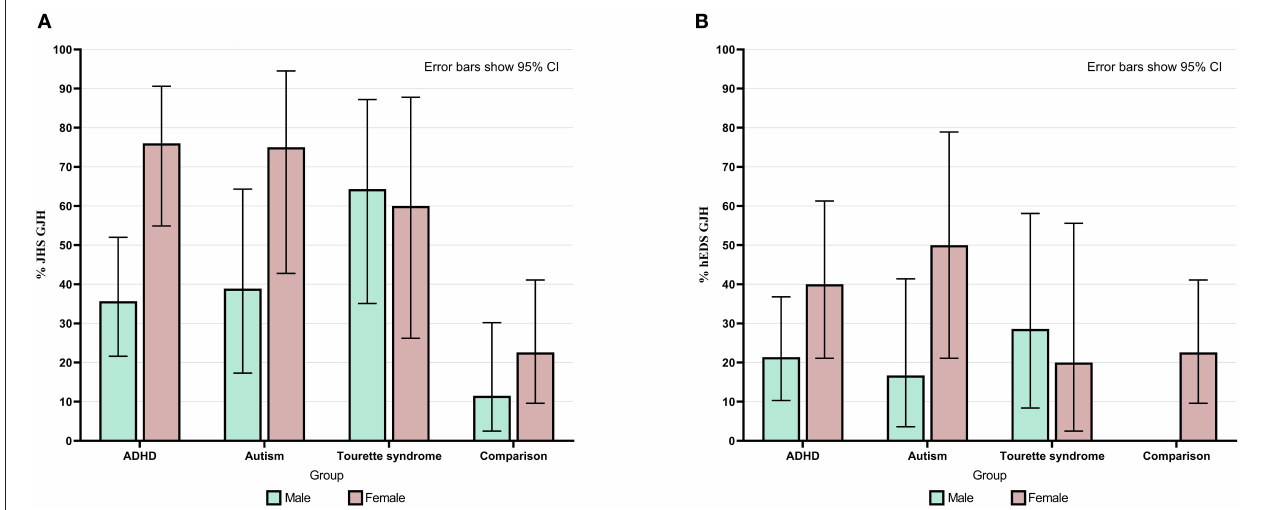
FIGURE 2 | (A) Percentage of individuals in each group and within each sex who had generalized joint hypermobility according to JHS criteria (Beighton score ≥ 4). (B) Percentage of individuals in each group and within each sex who had generalized joint hypermobility according to 2017 hEDS criteria (age specific cut-off). Error bars show 95%